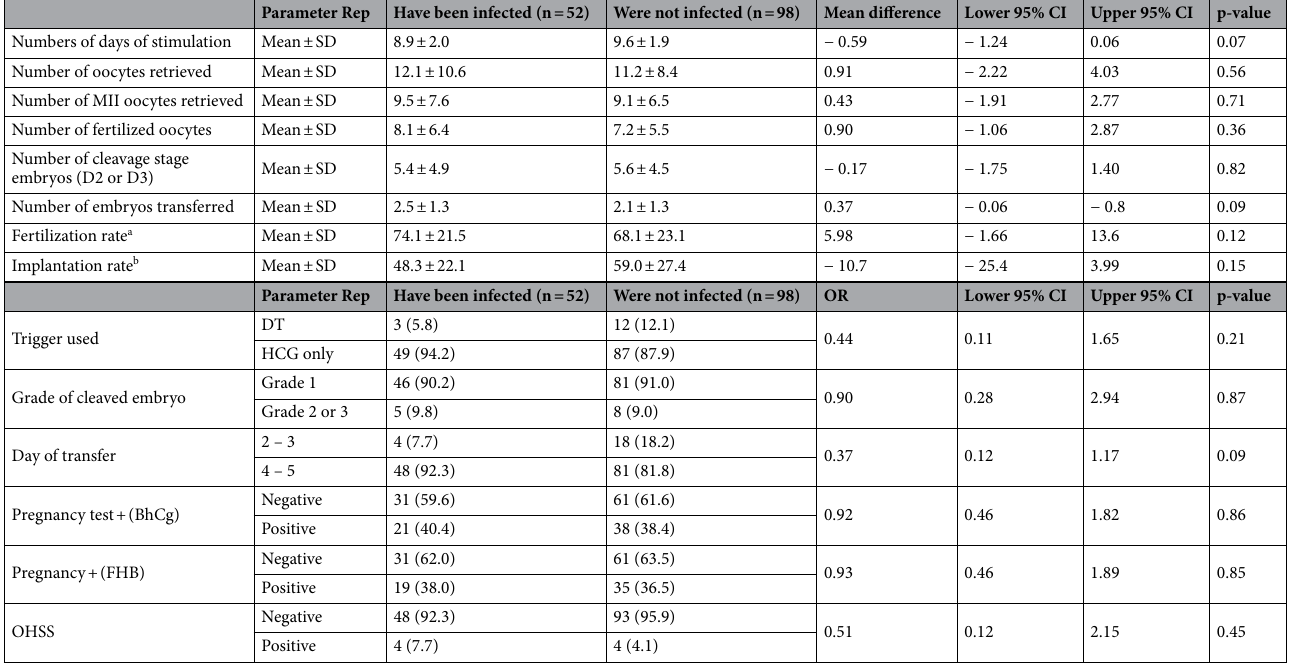
Table 2. COVID-19 and IVF parameters outcome. SD standard deviation, DT dual trigger, BhCG beta human chorionic gonadotropin, HCG human chorionic gonadotropin, OHSS ovarian hyper-stimulation syndrome, OR Odds ratio, CI Confidence interval. a Fertilization rate is defined as the percentage of fertilized oocytes from the collected oocytes. b Implantation rate is calculated as the number of gestational sacs observed per number of embryos